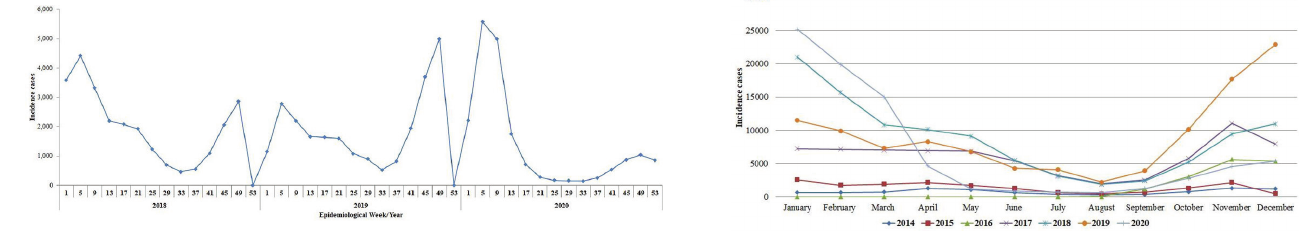
Figure 2 - Incidence of chickenpox (№ of cases) by epidemiological week and year.